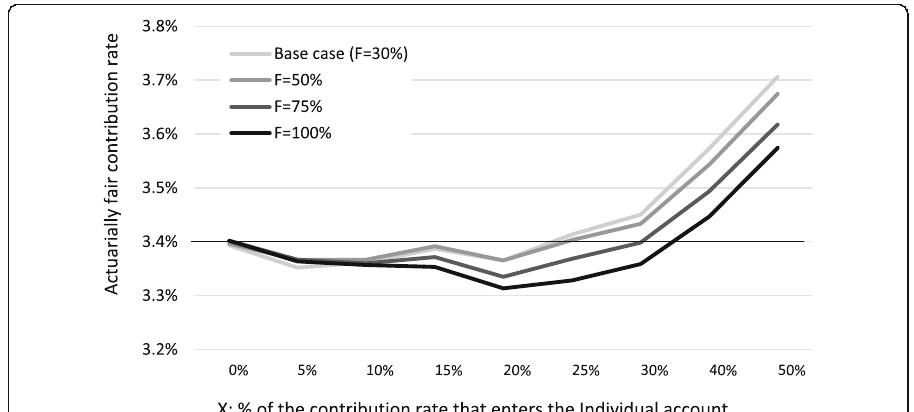
Fig. 2 Simulated actuarially fair contribution rate by X (the percentage of the contributions that goes to IUAs) and F (the percentage increase in the job finding rate during the self-financeable stage of the unemployment spell). Source: author ’ s calculation, using a simulated population. The pure risk-pooling average duration of unemployment is set to 6 months, whereas the average duration of employment is set to 60 months. The replacement rate is set at